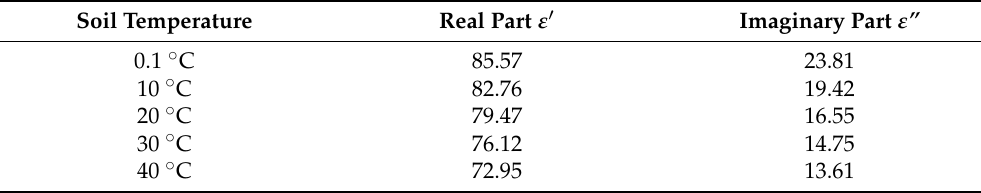
Table 2. Values for the real and imaginary part of the complex permittivity of free bulk water ε fw at different Soil